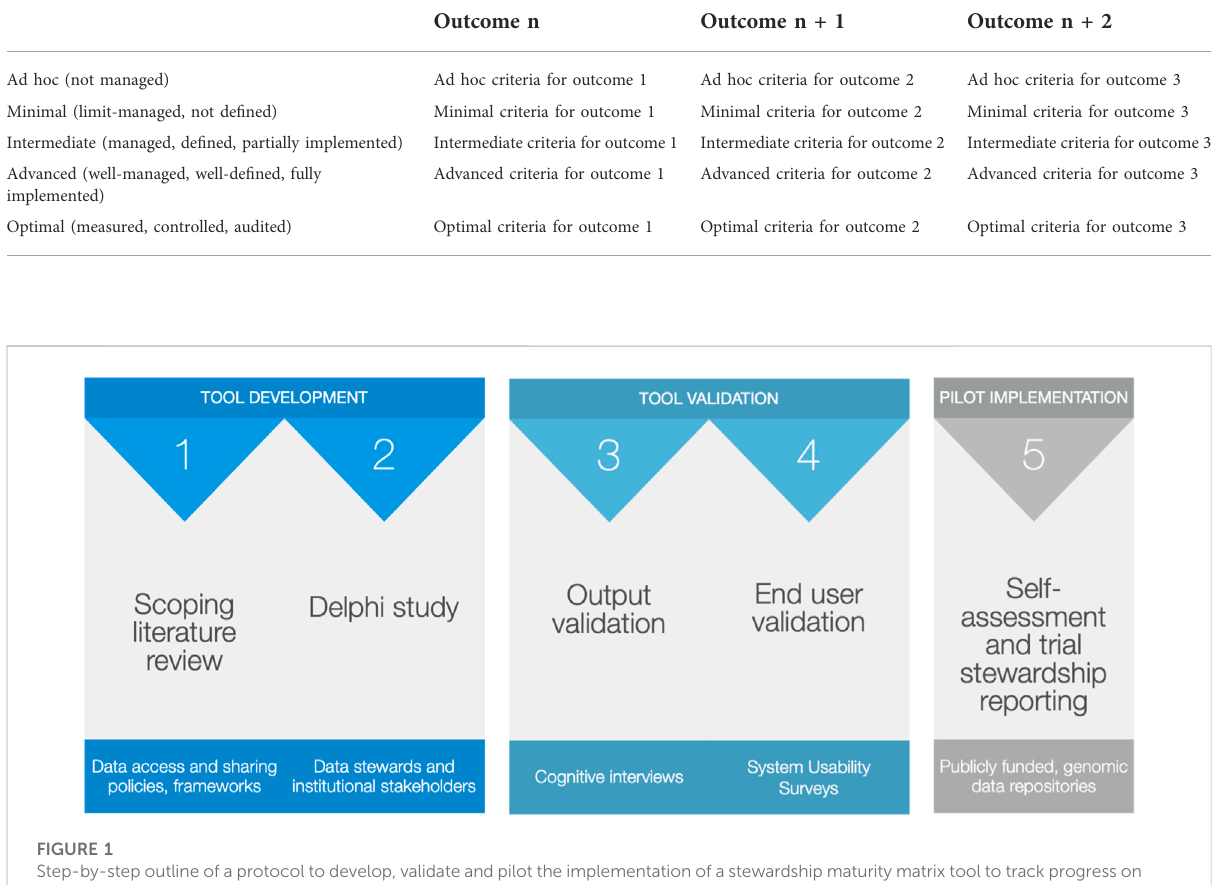
TABLE 2 Template stewardship maturity matrix that charts n stewardship outcomes of interest onto fi ve descriptive layers of organizational development.